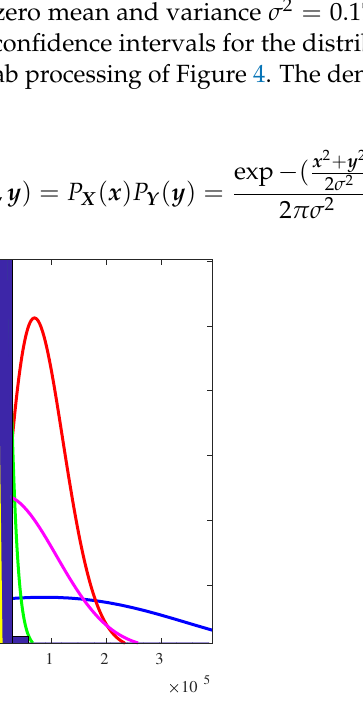
Figure 4. Distribution of the obtained